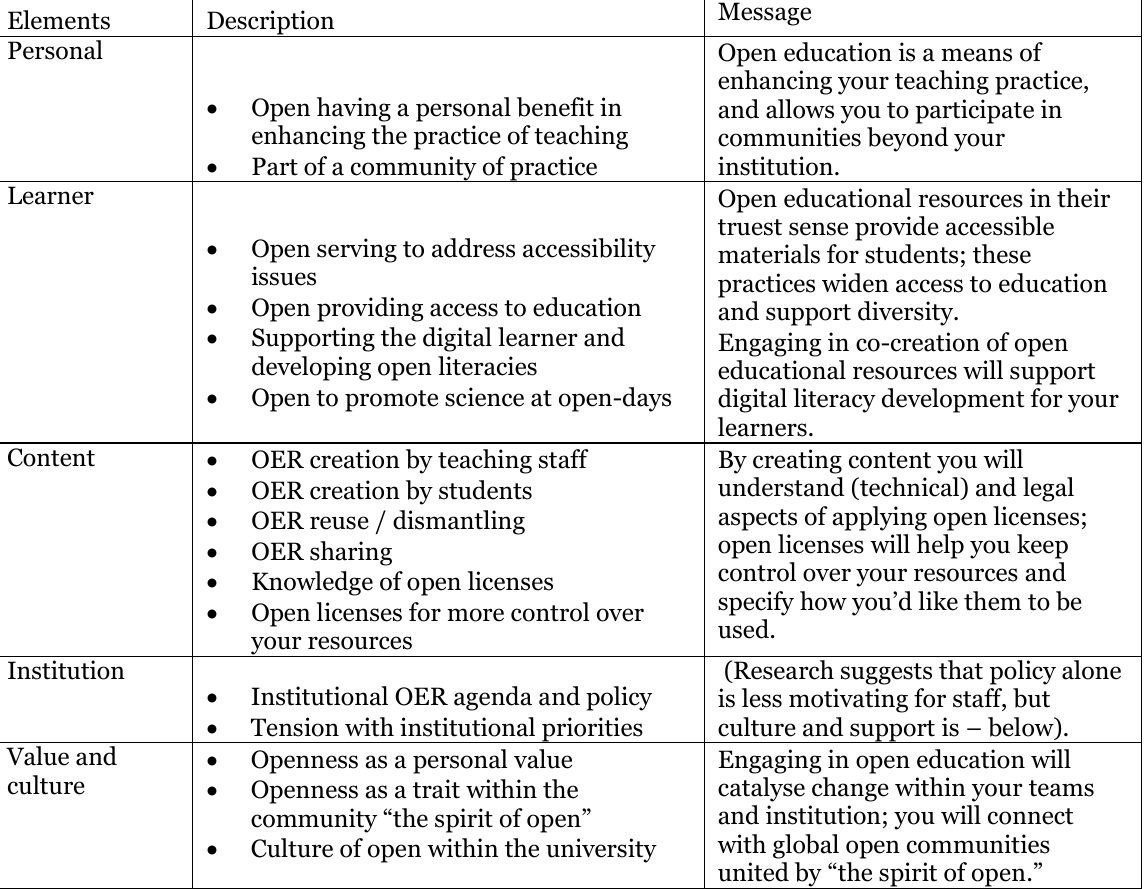
Linking the Five Elements to Messages That Could be Used in